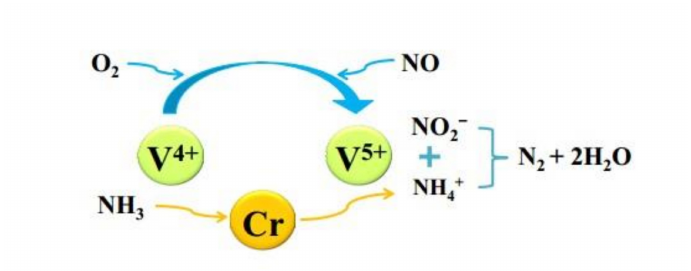
Figure 9. Mechanism of Cr doping improving sulfur resistance of Cr–V / TiO 2 catalyst